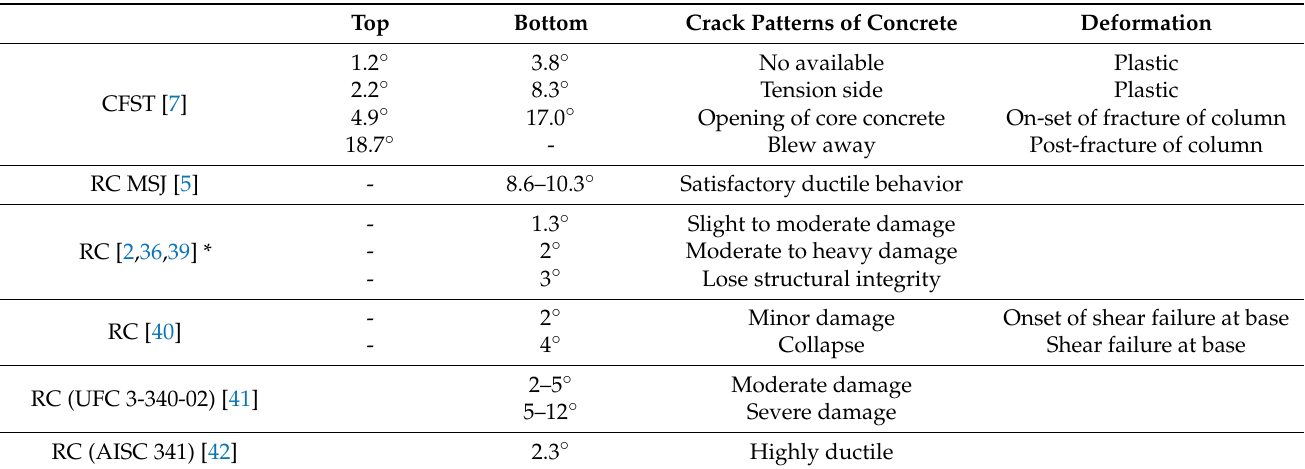
Table 2. Maximum support rotations (blast at low